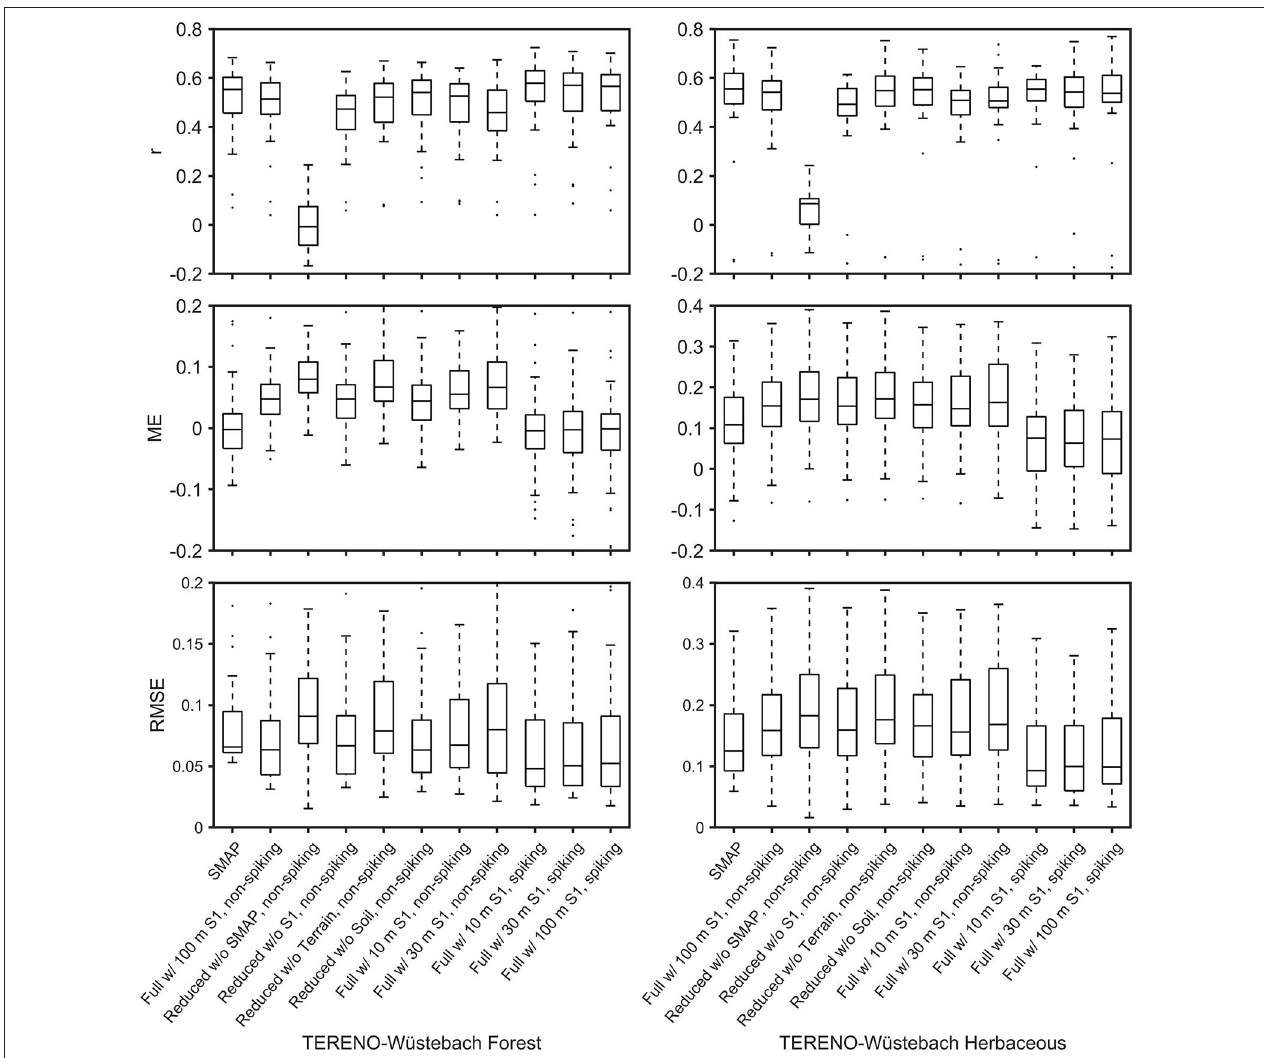
FIGURE 5 | Boxplots of the performance of SMAP L3 product (SMAP) and quantile random forest (QRF) models on individual field-scale validation station (TERENO-Wüstebach) evaluated by land cover (forest vs. herbaceous). The QRF models were first established without local training datasets using different input covariates including full model with Sentinel-1 aggregated at 100m (Full w/100m S1, non-spiking) and the corresponding reduced models by dropping SMAP (Reduced w/o SMAP, non-spiking), Sentinel-1 (Reduced w/o S1, non-spiking), terrain parameters (Reduced w/o Terrain, non-spiking), or soil properties (Reduced w/o Soil), and full models with Sentinel-1 aggregated at 10m (Full w/10m S1, non-spiking) and 30m (Full w/10m S1, non-spiking). QRF models were also established by including 10% local training stations at TERENO-Wüstebach (5 forest stations and 3 herbaceous stations, see Figure 1 ) with different resolutions of Sentinel-1 data (e.g., Full w/10m S1, spiking). R2, coefficient of determination; ME, mean error; RMSE, root mean squared